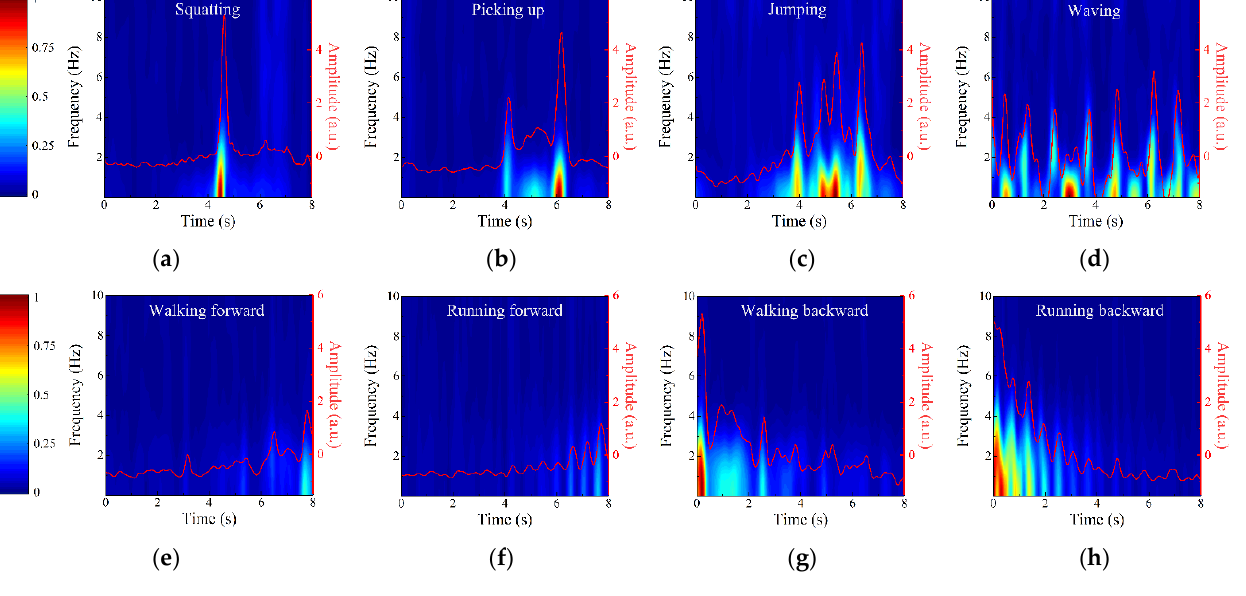
Figure 12. TF diagrams and the corresponding first principal components of ( a ) squatting, ( b ) picking up, ( c ) jumping, ( d ) waving, ( e ) walking forward, ( f ) running forward, ( g ) walking backward, and ( h ) running backward when ISR = 27.6 dB.